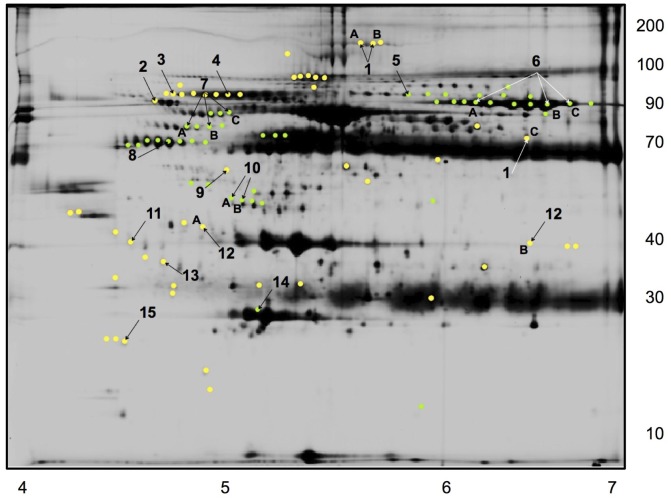
Bear serum proteomics.Representative images of a Cy2-stained black bear serum proteins separated by difference gel electrophoresis, utilizing a pH 4–7 (left to right) immobilized pH gradient isoelectric focusing gel strip for the 1st, horizontal separation and a 12% SDS-PAGE gel in the 2nd, vertical separation. Protein spots significantly (p<0.05) up-regulated (yellow) and down-regulated (green) proteins are indicated by colour. Protein spots that were subsequently identified by tandem mass spectrometry are indicated by numbers, which correspond to spot IDs in table 2. Estimated protein molecular weights in kiloDaltons (kDa) are indicated on the right edge of the image, and estimated isoelectric points are on the bottom edge.